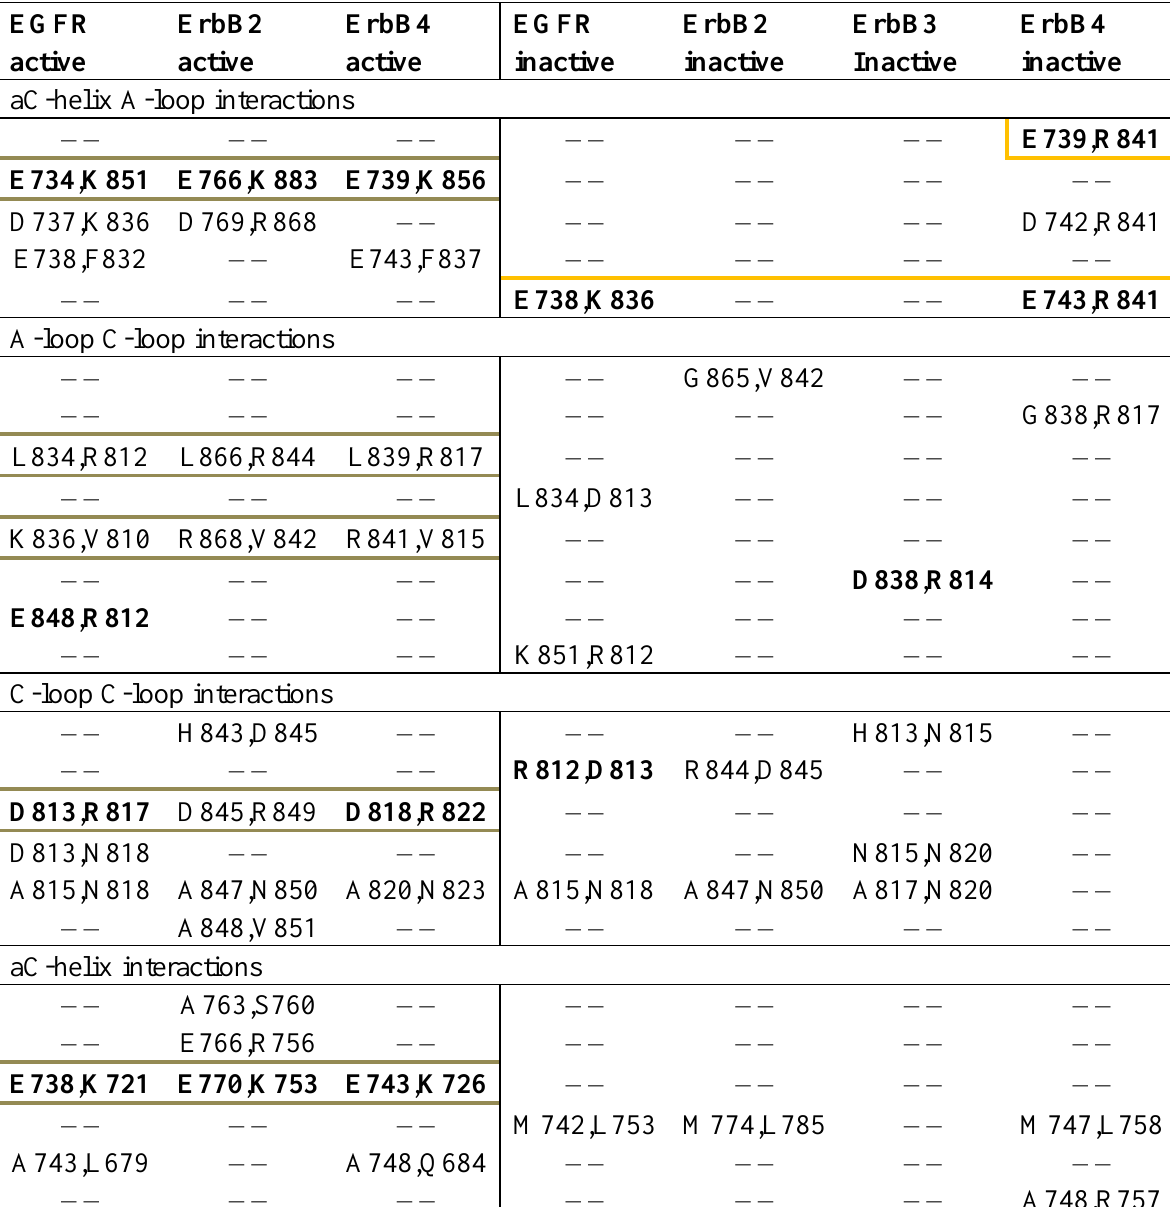
Table 4. Persistent hydrophilic interaction network in ErbB kinase monomers; bolded entries are salt bridges while non-bolded entries are hydrogen (H-bonds). The entries are aligned so homologous interactions are in line. The conserved active interactions are boxed in brown, while the sequestering interactions are boxed in